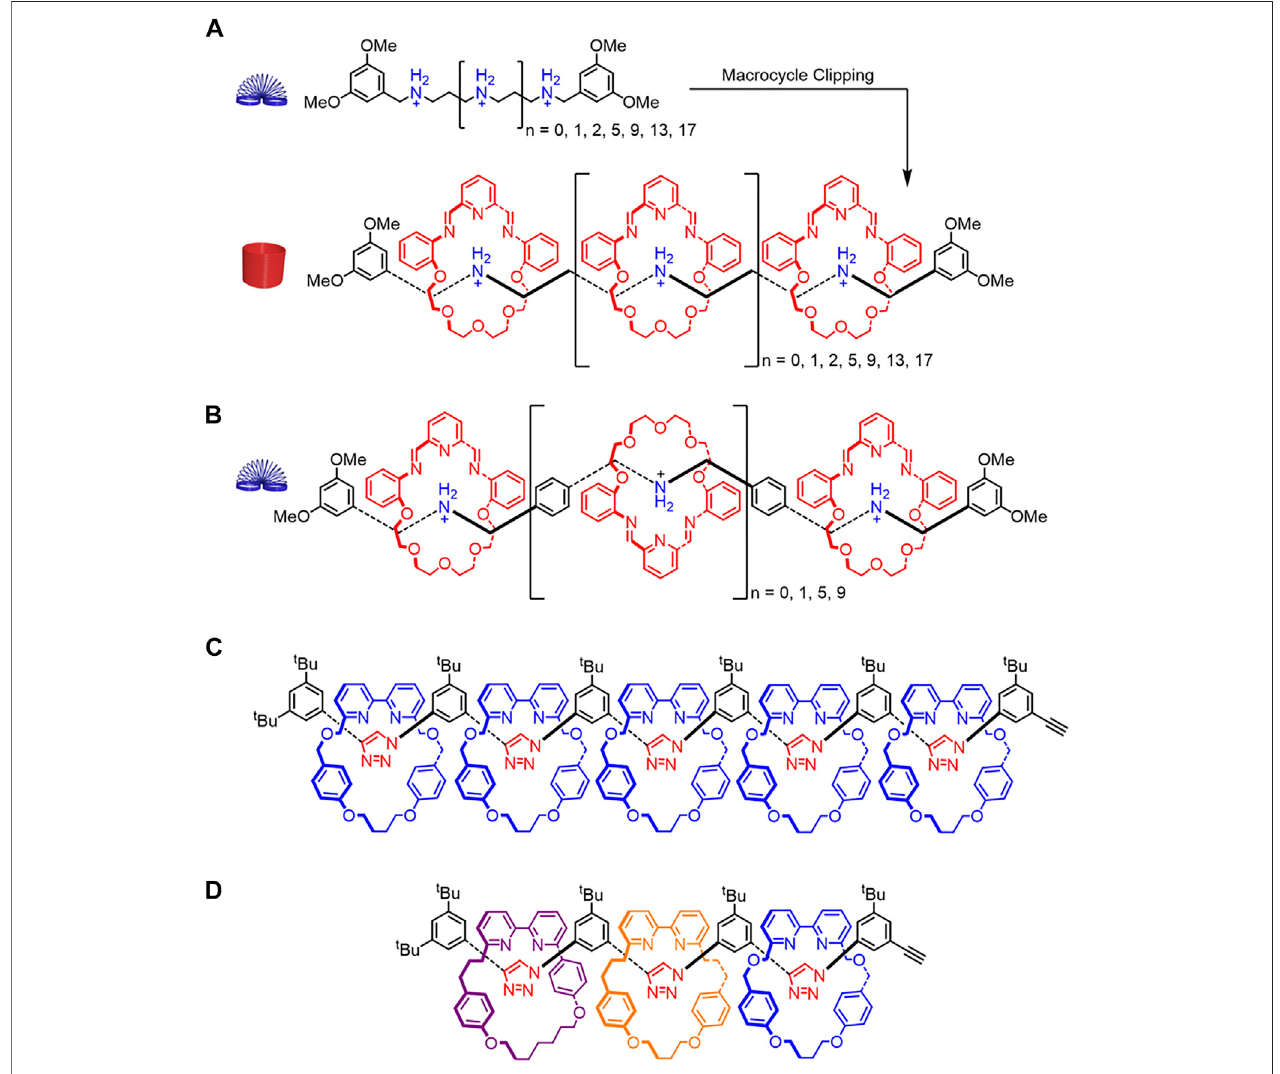
FIGURE 12 | (A) Structures of the thread and rigidi fi ed rotaxane resulting from π stacking between the semi-rigid macrocycles spaced 3.5 Å apart on a fl exible thread. (B) Amore fl exiblerotaxanewherethedistancebetweenbindingsitesislargerthan3.5 Åand π - π stackingisinterrupted. (C) Homo[6]rotaxaneand (D) hetero[4] rotaxane containing rare all- syn triazole